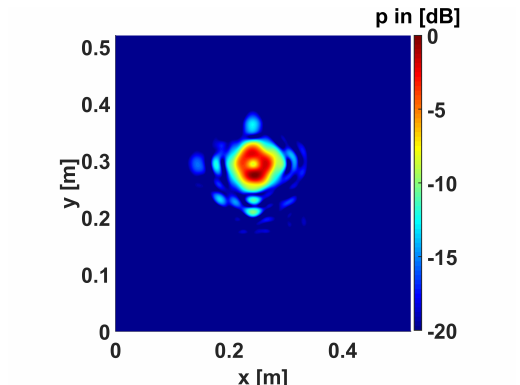
Figure 17. Amplitude at the top of the wooden particleboard with a ø20 mm piece of paper. Evaluated with the spec-radiation method, for the frequency 48–52 kHz, with an original grid point distance of d x = d y = 18 mm enhancet to d x Virt = d y Virt = 2 mm and a grid of the size 512 mm × 512 mm.